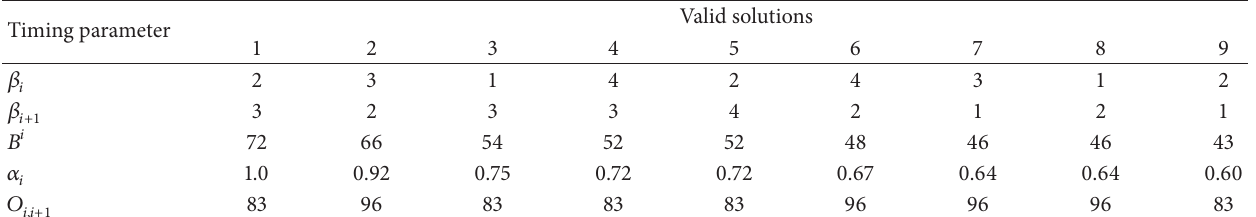
< 𝐺 , 2nd Steet and Mill Street). IBT ,𝑖+1 IBT ,𝑖